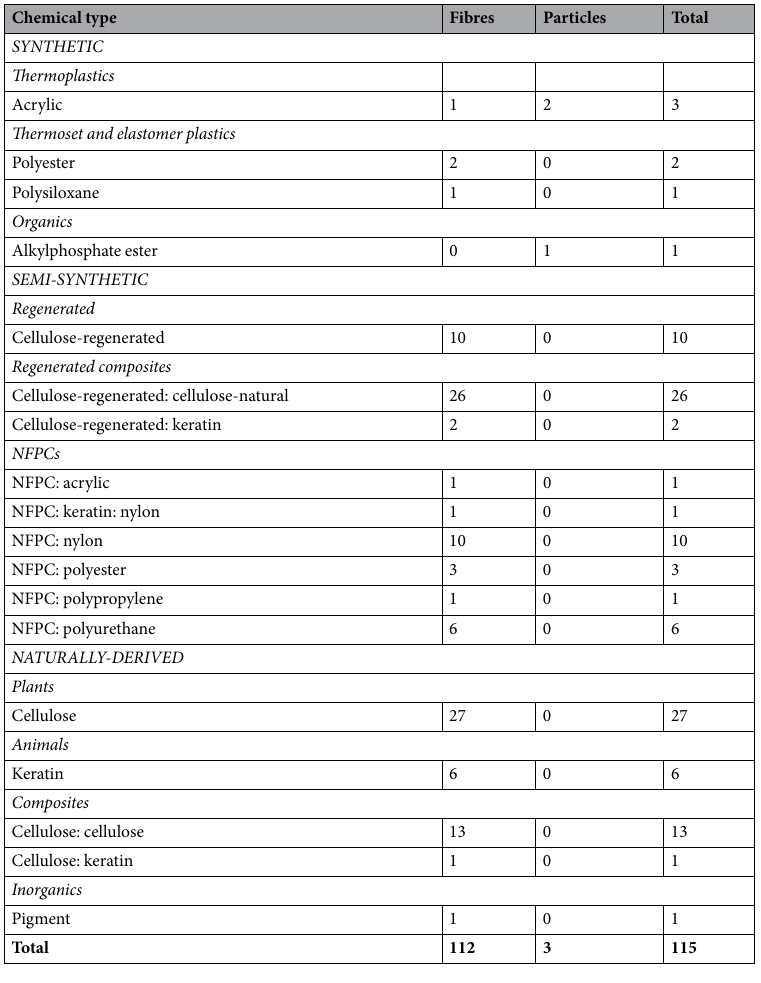
Table 3. Chemical type assignment of marine microdebris in juvenile coral trout. A total of 115 marine microdebris items (112 fibres, three particles) were detected in the gastrointestinal tract of 20 similarly-sized juvenile coral trout ( Plectropomus leopardus and P. maculatus ) collected on reefs around four reef islands in the Great Barrier Reef World Heritage Area, Australia, in 2011. Assignment was based on the chemical type as determined by ATR-FTIR, results from Compare analyses, and visual inspection of photographs. Items were classified as synthetic, semi-synthetic, or naturally-derived. NFPC = natural fibre reinforced